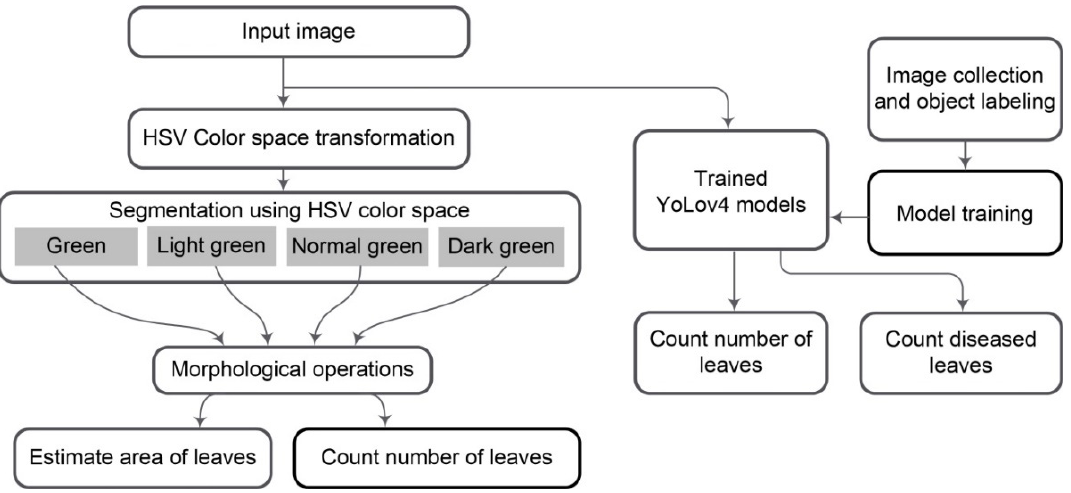
Figure 8. Leaf trait identification process. Morphological operations are performed on contour area of leaves measurement and leaf colour classification. The area of grey colour represents the different colour levels of green. Two YoLov4 models were developed to count number of leaves and leaf disease.